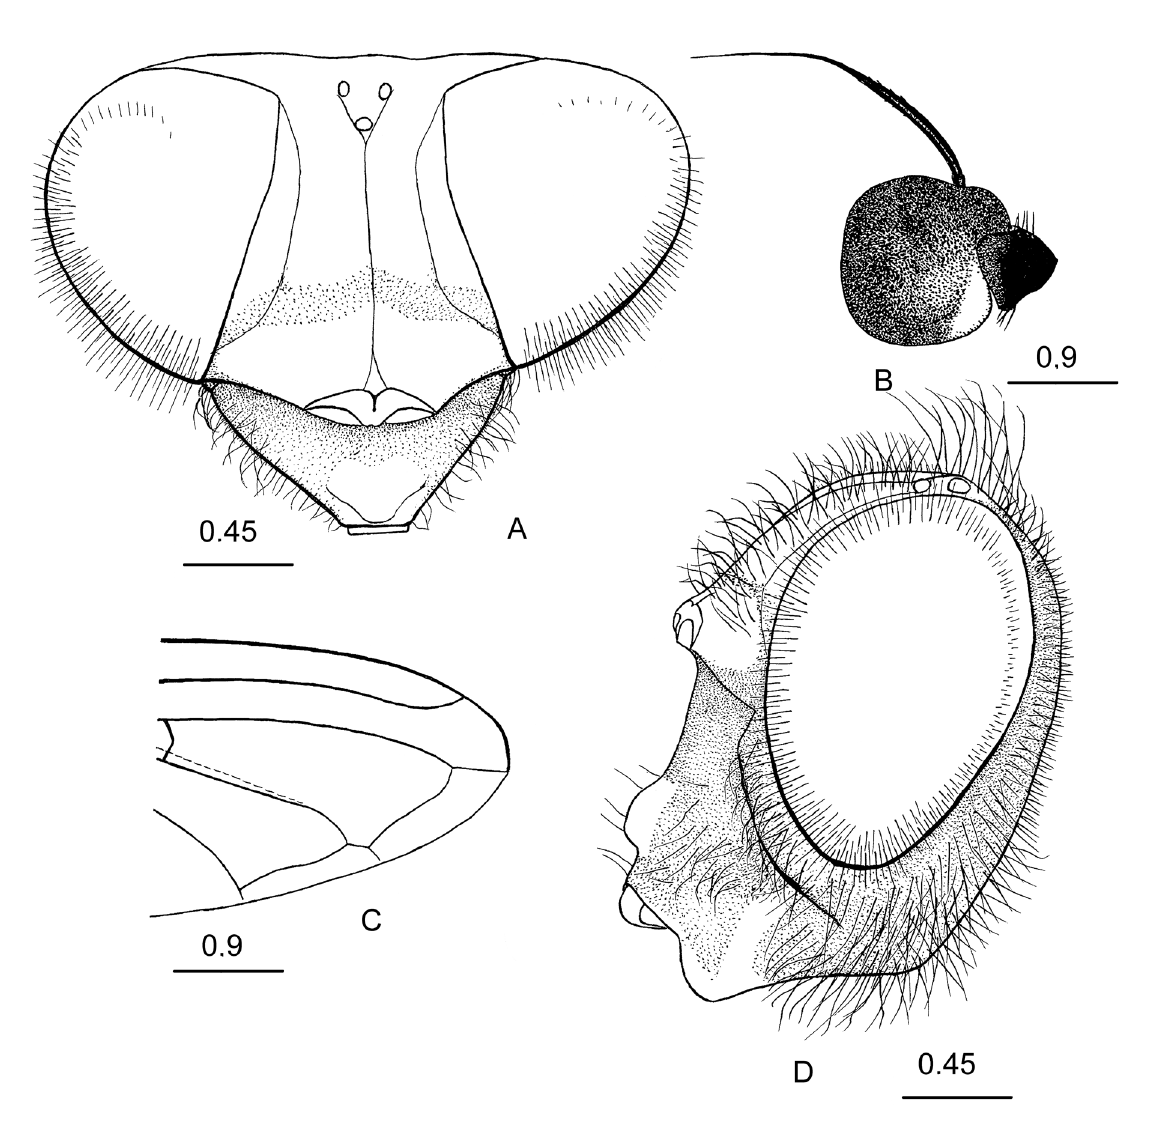
Fig. 25. Cheilosia ( Montanocheila ) gilva sp. nov., paratype, ♀ (CSCA). A . Head, dorsal view. B . Antenna, lateral view of pedicel and basoflagellomere. C . Tip of wing. D . Head, lateral view. Scale bars indicated in